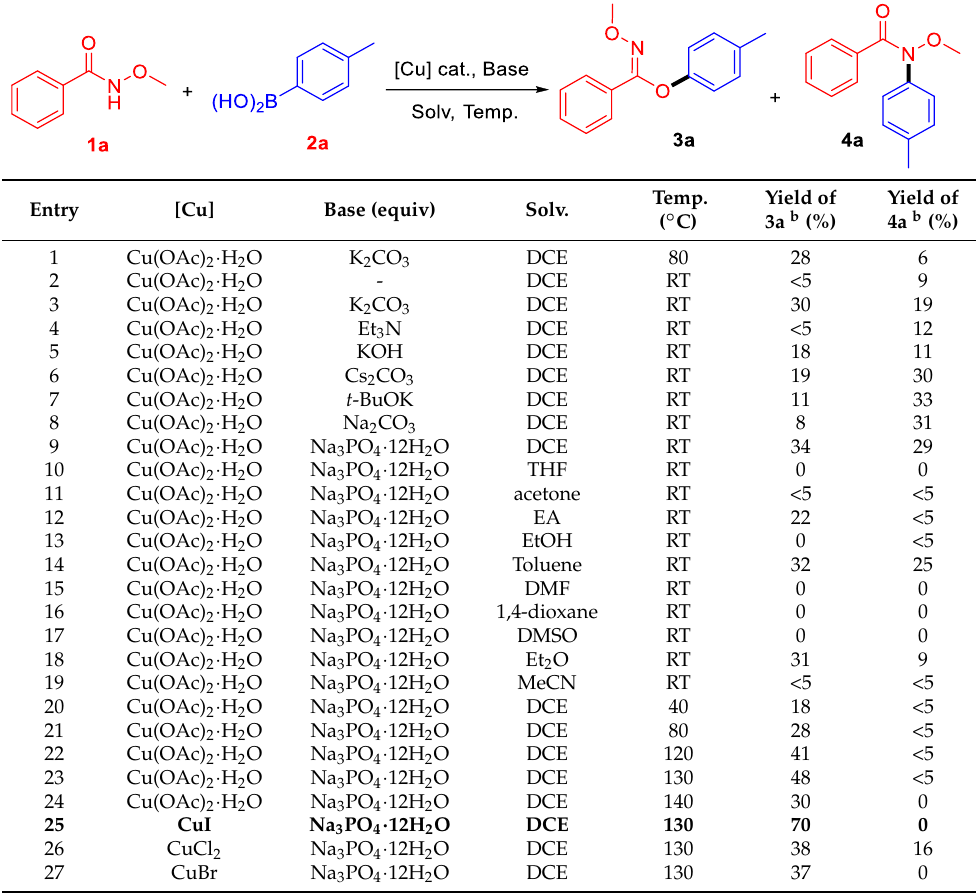
Table 1. Optimization of the reaction conditions a .